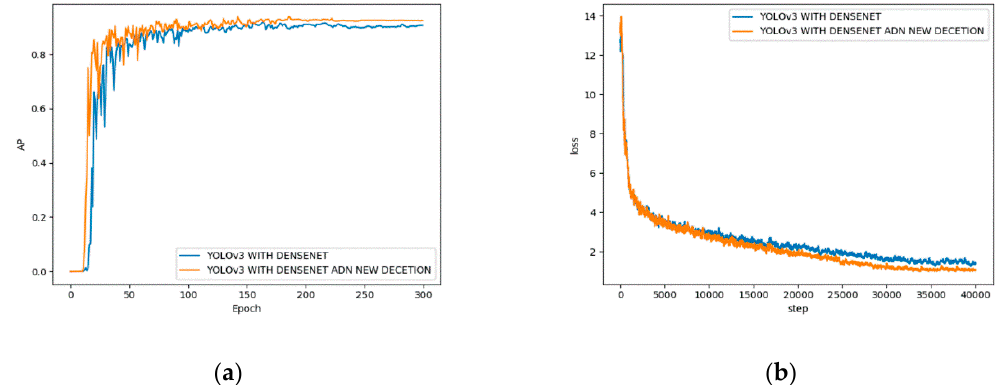
Figure 16. ( a ) AP curve of different detection scale; ( b ) loss curve of different detection scale.